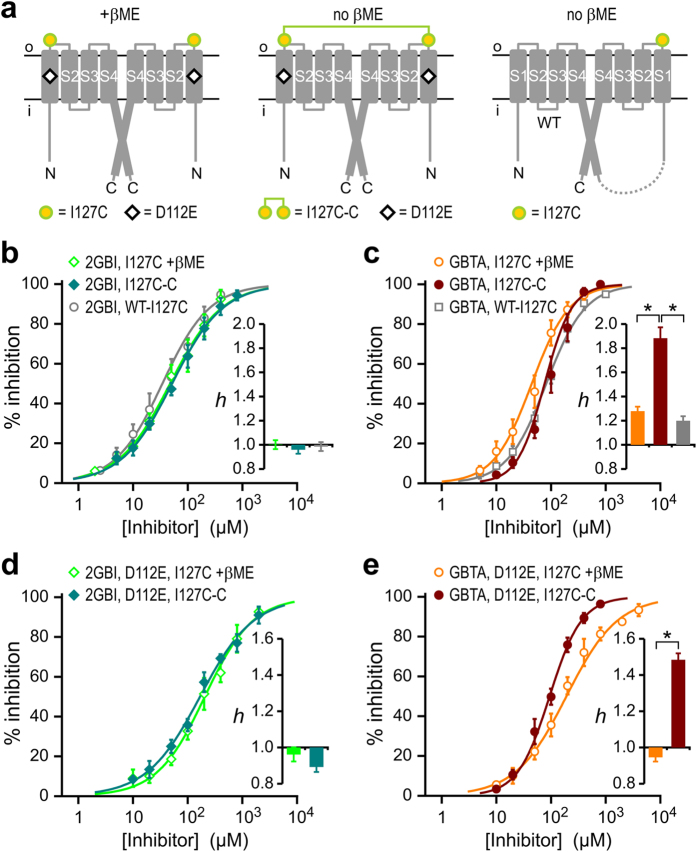
Open-state coupling is mediated by direct physical interaction between outer ends of S1 segments in the two subunits.(a) Schematics of mutant Hv1 dimers and linked dimers designed to study how intersubunit cysteine crosslinking affects GBTA binding cooperativity. (b–d) Concentration dependences of inhibition of the indicated constructs by 2GBI (b,d) and GBTA (c,e) in the presence or absence of 10 mM βME in the extracellular solution. Each point represents the average inhibition from 3 to 10 measurements ± S.D. Curve lines are Hill fits used to obtain Kd values (see Supplementary Table 1). Hill coefficients in inset histograms were determined from fits reported in Supplementary Figs 3 and 4. Asterisks in (c,e), indicate statistically significant differences between different conditions of GBTA inhibition (p < 0.0001, see methods). Corresponding differences for 2GBI inhibition [(b,d)] were not statistically significant (p > 0.05).